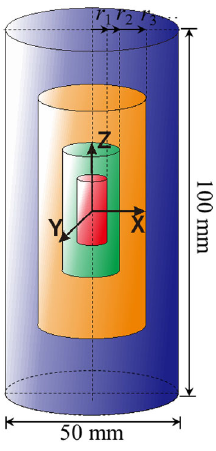
Fig. 4 Schematic diagram of cylindrical coverage of